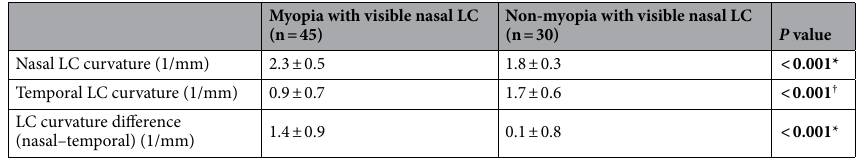
Table 3. Comparison of nasal and temporal curvatures of LC between myopia and non-myopia. Except where indicated otherwise, values are mean ± standard deviation. *Comparison was performed using the Student t test. † Comparison was performed using the Wilcoxon signed-rank test. Statistically significant values are shown in bold ( P < 0.05). LC: lamina cribrosa.